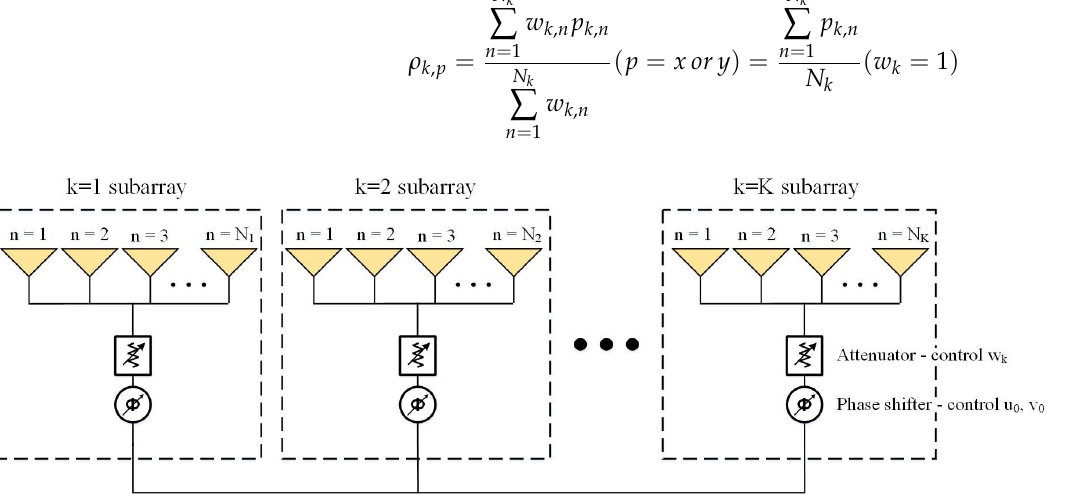
Figure 1. Phased array antenna with a